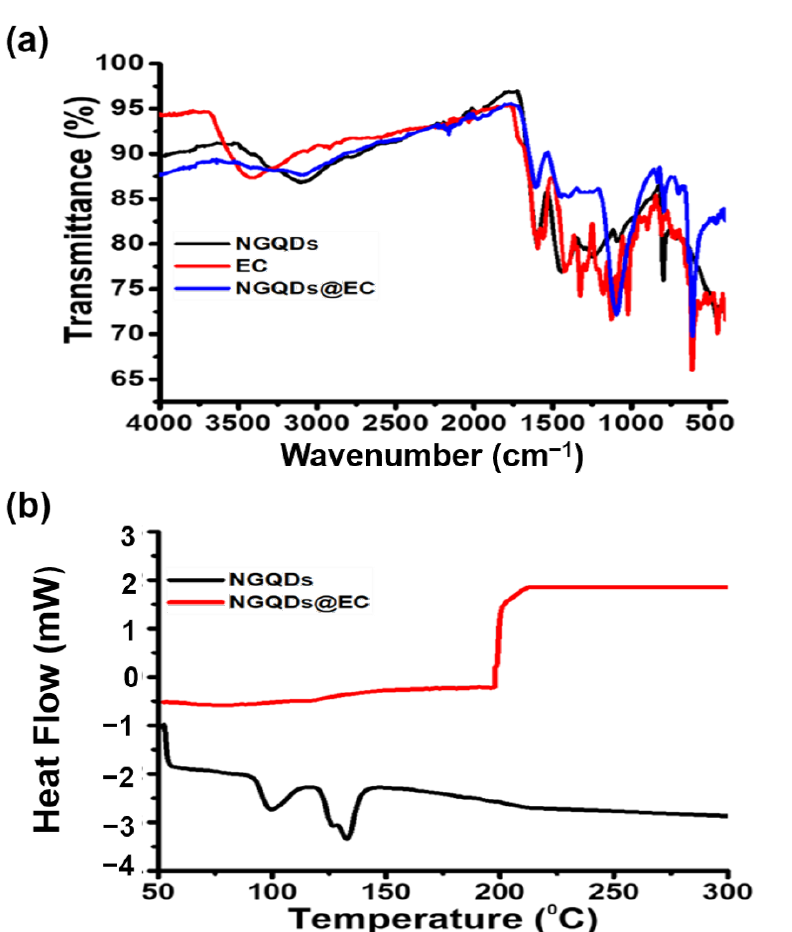
Figure 3. ( a ) FTIR spectra of EC (red line), NGQDs (black line), and NGQDs@EC (blue line) photo- catalysts respectively, and ( b ) DSC of NGQDs@EC (red line) and NGQDs (black line) photocatalyst respectively.